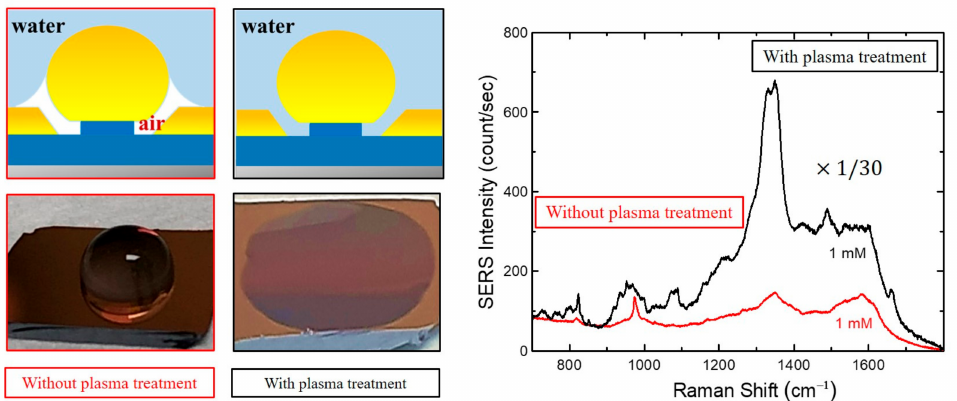
Figure 5. SERS spectra measured from Au nanogap samples with the plasma treatment (black), prior to TNT coating, and without plasma treatment (red) for TNT/water. The concentration is 1 mM for both samples, and the measurement conditions are the same as described in the Method section. Images at the left show the hydrophobic and hydrophilic surface states before and after the plasma treatment,